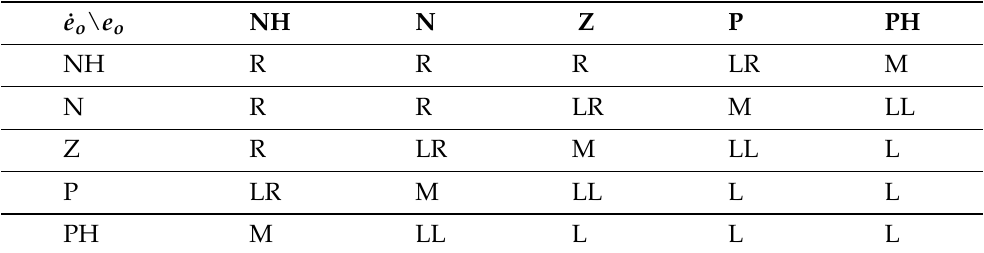
Figure 7. ( a , b ) represent the input membership functions. The range of these membership functions extends from − ∞ to + ∞ . ( c ) represents the output membership function of the fuzzy logic system. The fuzzy labels are defined as NH: Negative High, N: Negative, Z: Zero, P: Positive, PH: Positive High, R: Right, LR: Little Right, M: Medium, LL: Little Left, and L: Left. Table 2. Rule base of the fuzzy logic